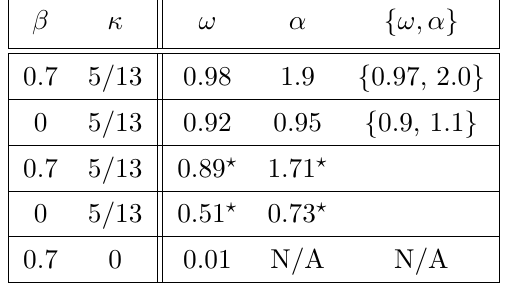
Table 1 . Best-fit parameters in the Brody distribution for ( L = 17 , R = 4 , S = 3) with ( β 6 = 0 , κ 6 = 0) , ( β = 0 , κ 6 = 0) and ( β 6 = 0 , κ = 0) . The value of ω is first fitted with α fixed to either 1 or 2, then α is fitted with ω fixed in the chaotic cases, and finally both values are fitted. The values are calculated with the 10% of highest and lowest energies removed. Those marked by ? are calculated for only the lowest 6% of